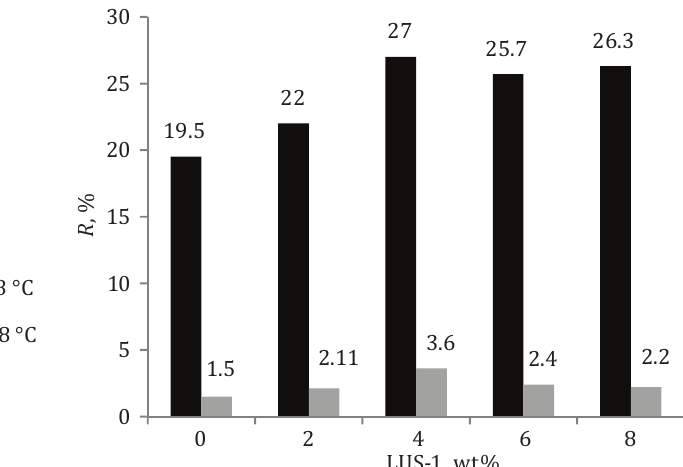
Figure 15. Effect of stress levels on recovery percent of asphalt binders